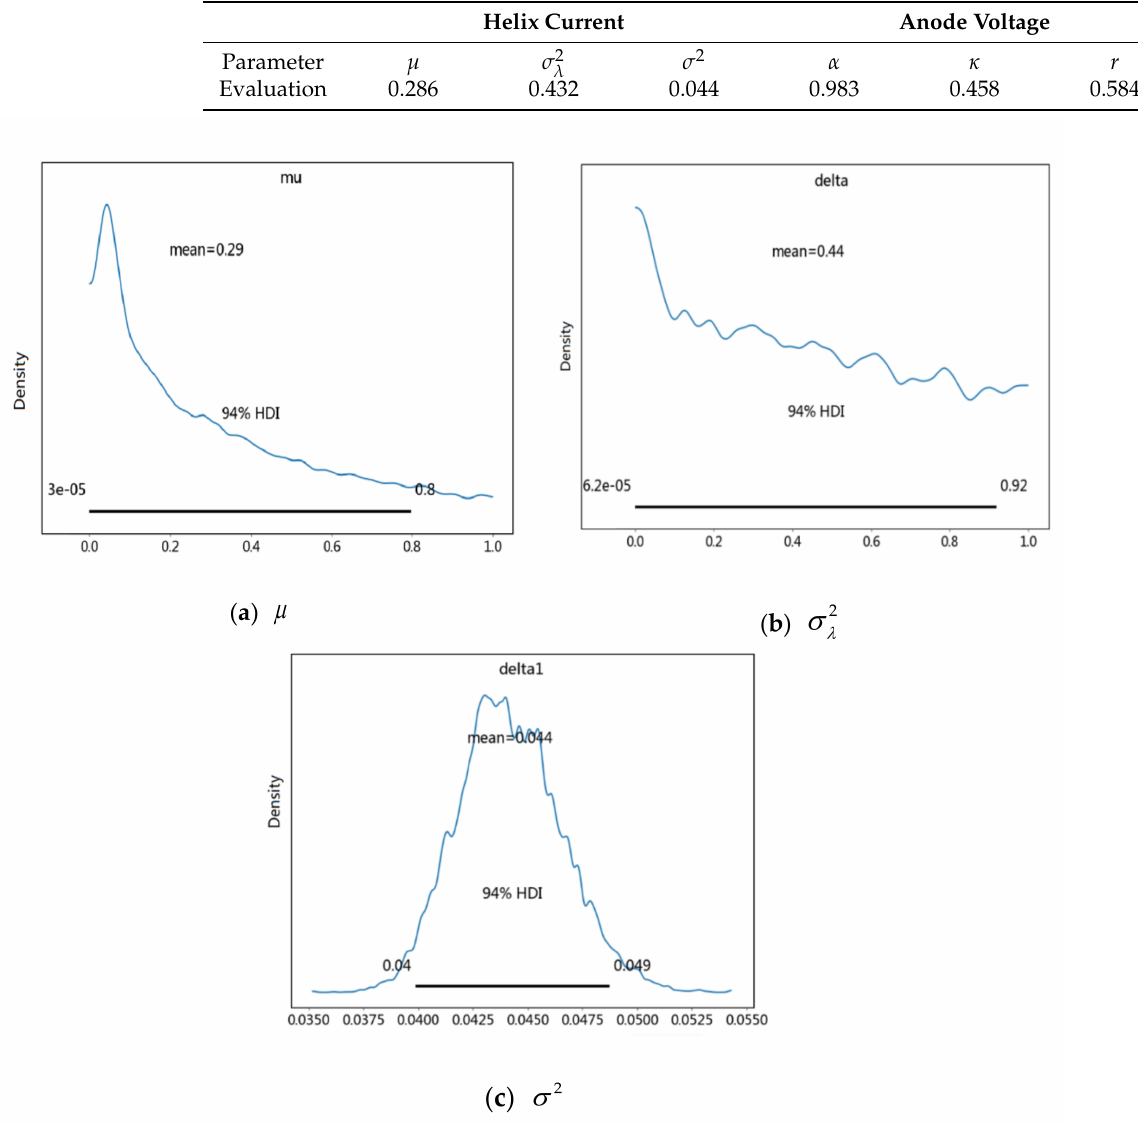
Figure 4. The parameter posterior distribution of the helix current, ( a ) µ , ( b ) σ 2